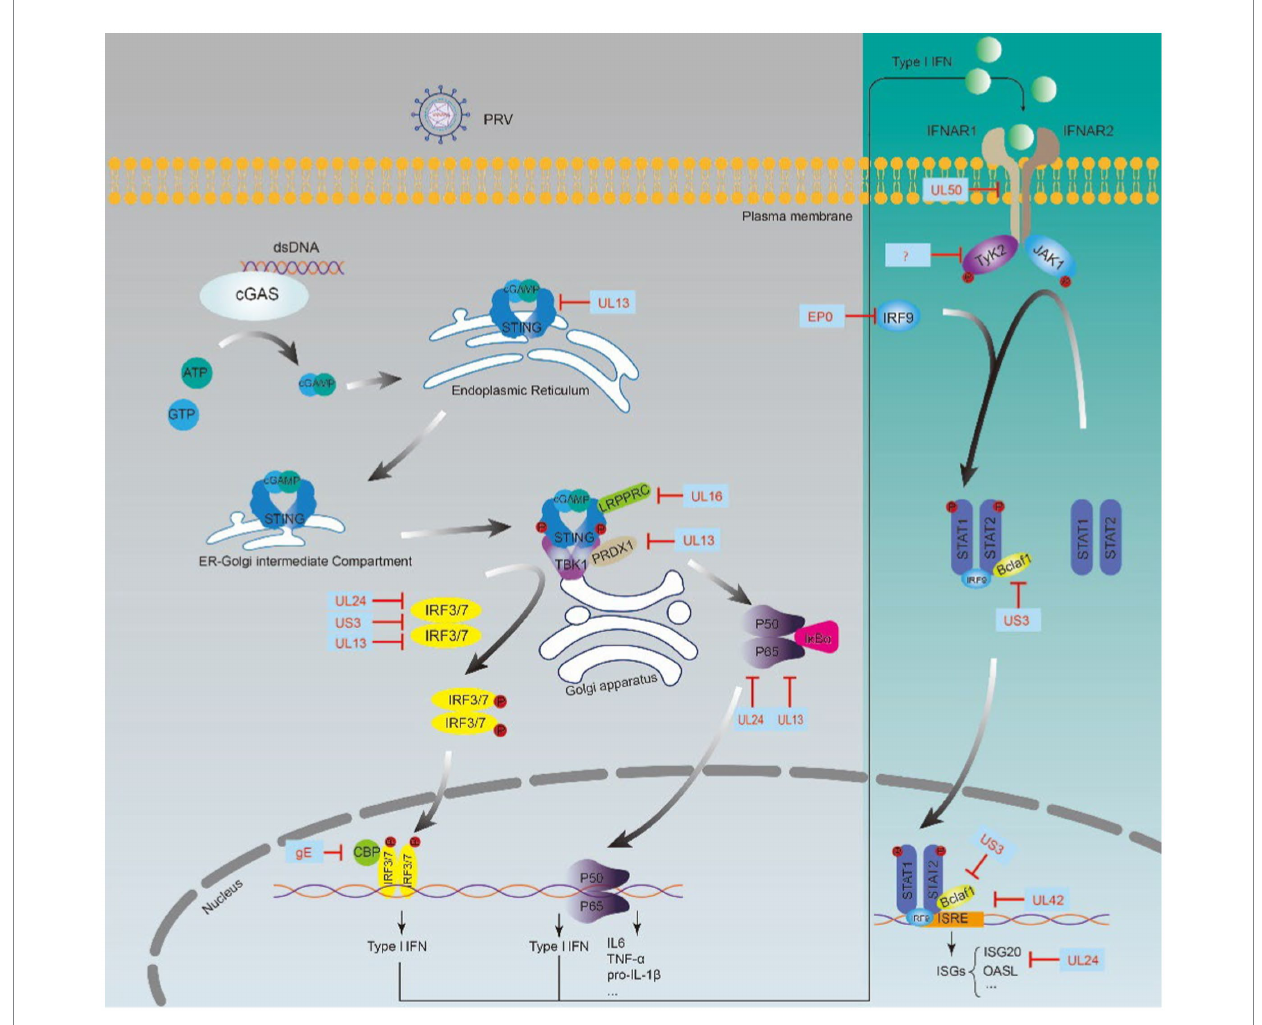
FIGURE 1 PRV regulates IFN-mediated innate immune responses by encoding multiple